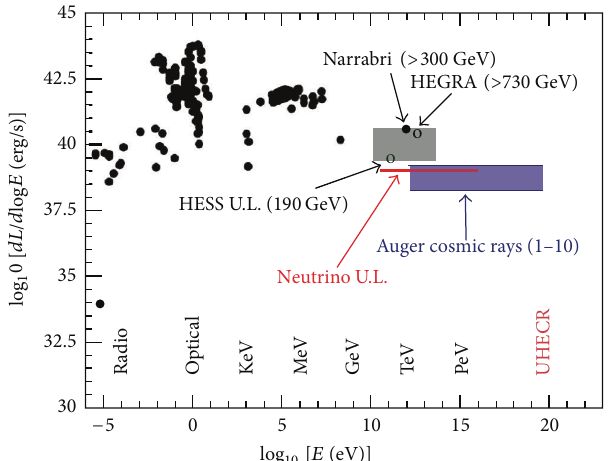
Figure 5: Spectral energy distribution of Cen A (black dots). Keeping in mind that the source is variable, we show our estimates for the flux of TeV gamma rays (upper gray shading) and cosmic rays assuming that between 1 and 10 events observed by Auger originated at Cen A (lower blue shading). We note that cosmic-ray and TeV gamma-ray fluxes estimated in this paper are at a level of the electromagnetic component shown from radio waves to GeV photons. Our estimate for the neutrino flux (labeled “neutrino upper limit”; see text) is shown as the red